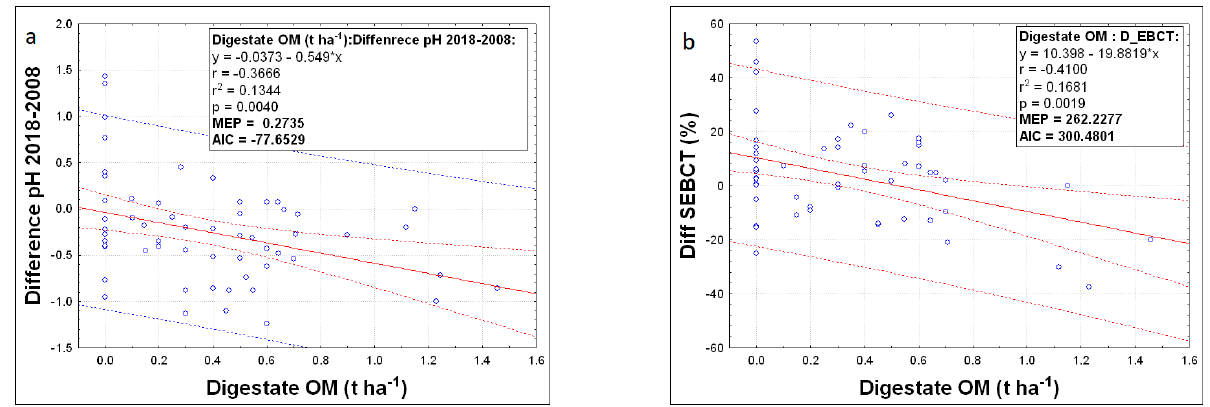
Figure 4. Dependence of ( a ) pH and ( b ) SEBCT difference (2018–2008) on OM dose applied in digestate. Decreasing of soil reaction (pH/KCl) caused the changes in the sorption complex.